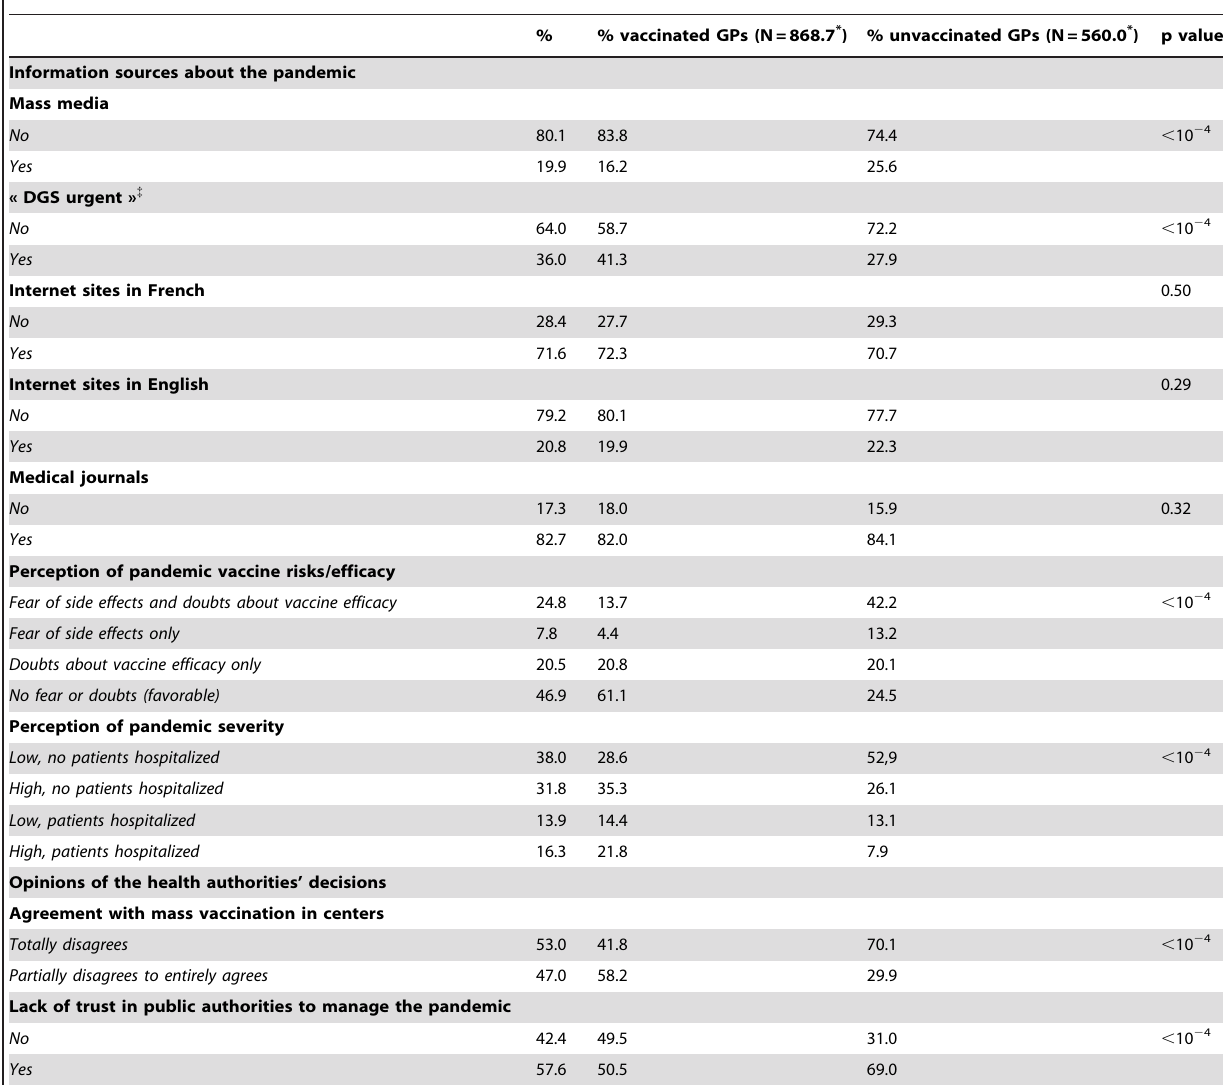
Table 2. Opinions and attitudes of GPs according to their vaccination status for A/H1N1 flu (French nationwide panel of general practitioners, weighted data,